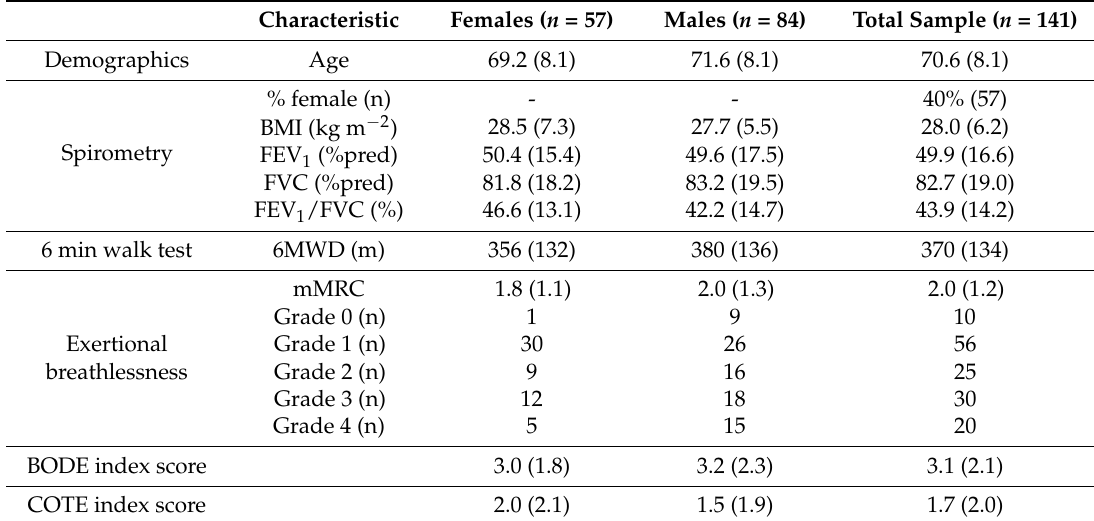
Table 1. Baseline data—Physiological.